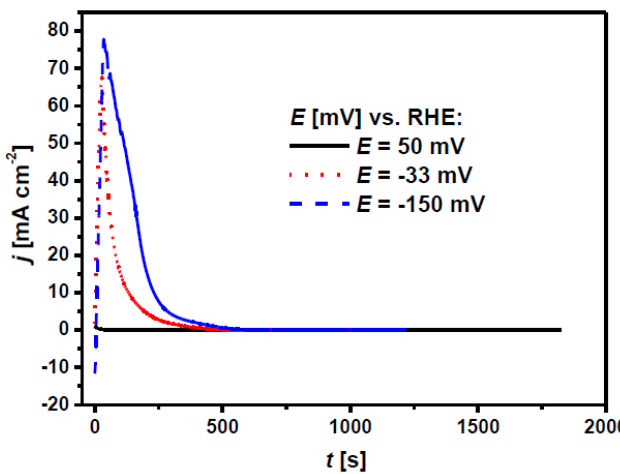
Figure 5. Hydrogen oxidation currents after hydrogen electrosorption at potentials corresponding to formation of α phase ( E = 50 mV), α - β phase transition ( E = − 33 mV) and β phase ( E = − 150 mV) at 50 µ m Pd 80 Rh 20 electrode in 0.1 M H 2 SO 4 at 25 ◦ C.